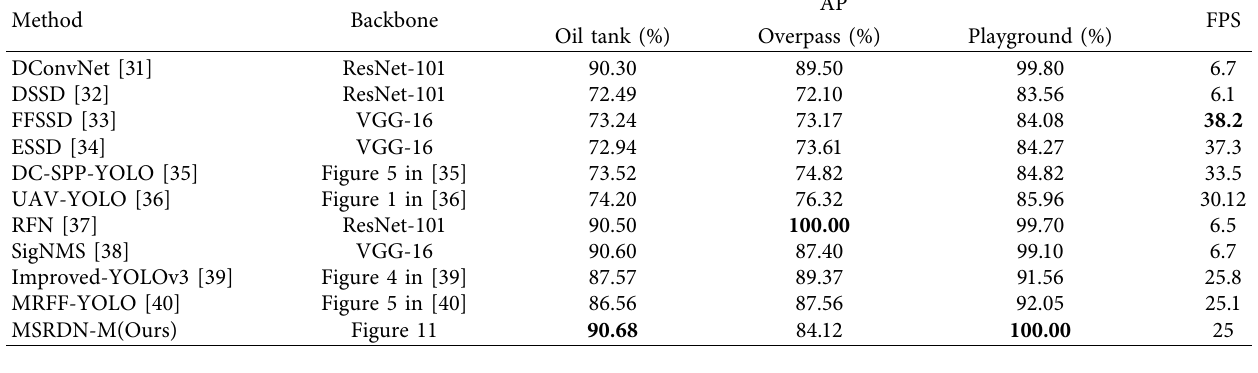
Table 4: The comparison of multiple algorithms on AP for the other three classes.